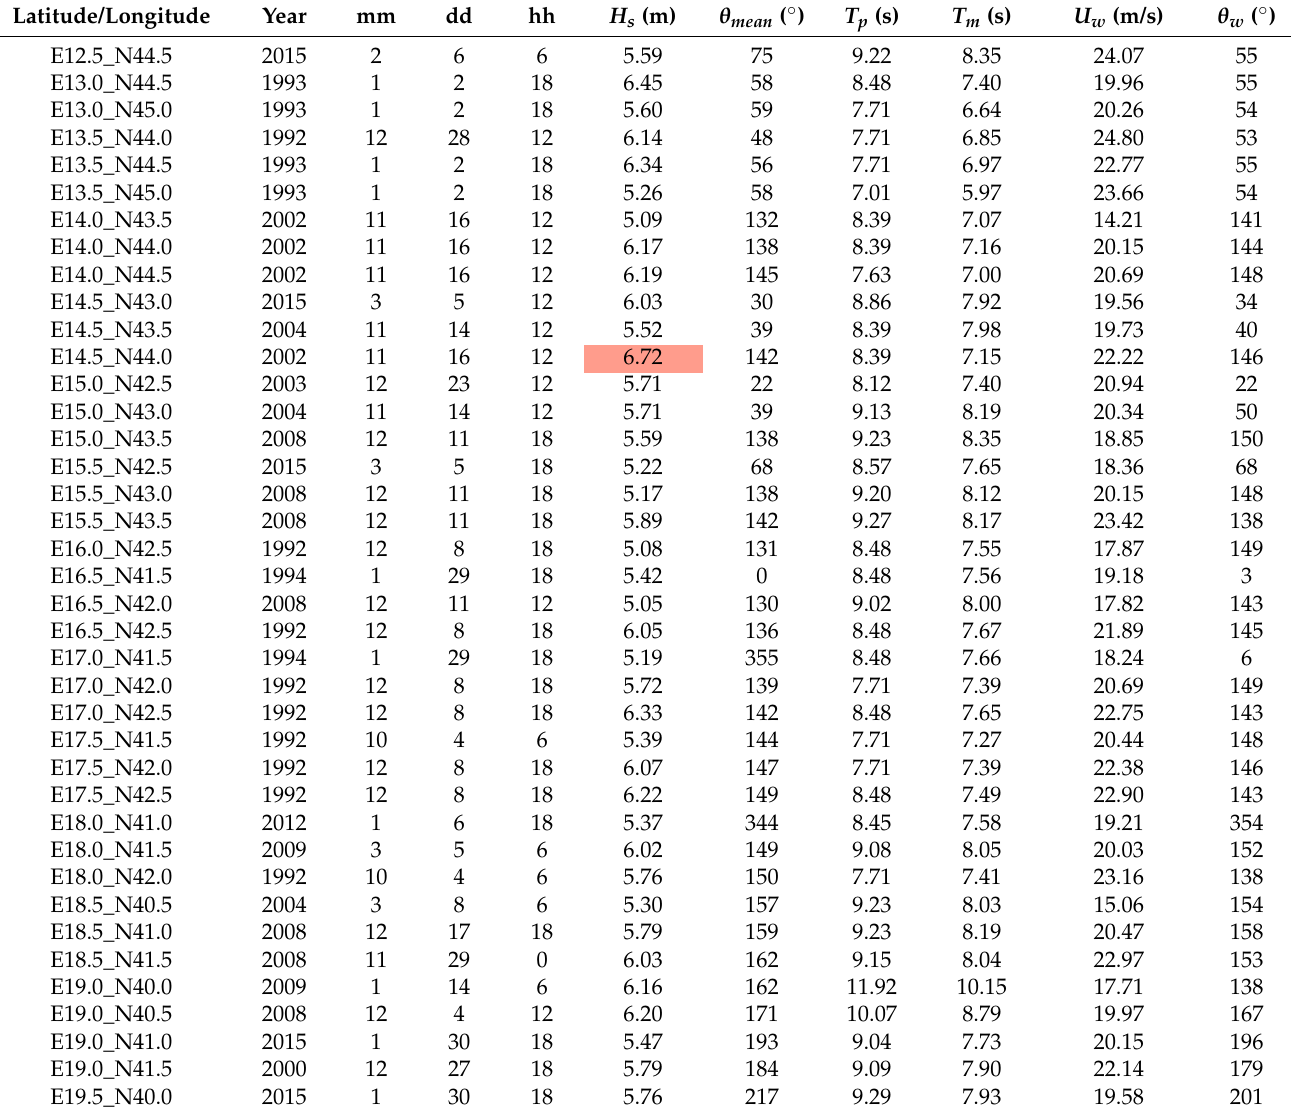
Table A3. Maximum recoded wave heights, Hs , per location with accompanying parameters. Maximum marked in red.